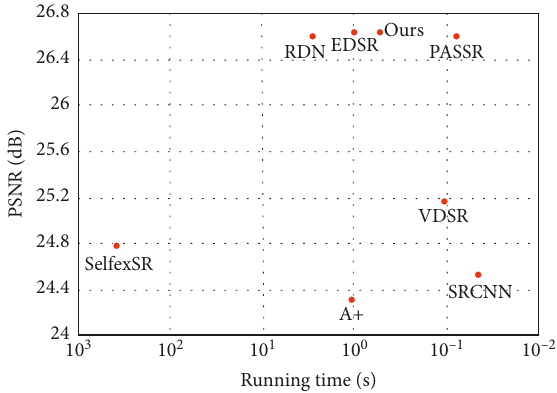
Figure 11: Runtime versus performance. The results are evaluated on the Urban100 dataset for scale factor 4. The proposed strides a balance between reconstruction accuracy and execution